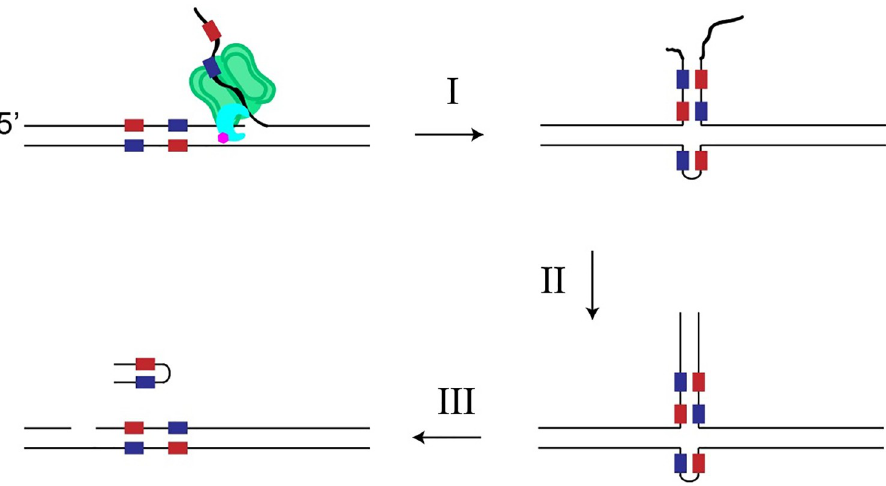
Fig 6. A scheme for amplification of hairpin DNA. (I) Replisome dissociation and DNA branch migration produce a cruciform structure at a suitable inverted repeat sequence, depicted as red and blue blocks. (II) 3’ exonuclease activity of WT gp5 enables extension of the cruciform intermediate. Extension may restart at either the first or second instance of the inverted sequence. (III) Another round of nicking allows for hairpin release. Hairpin release may be assisted by another round of polymerization from the DNA